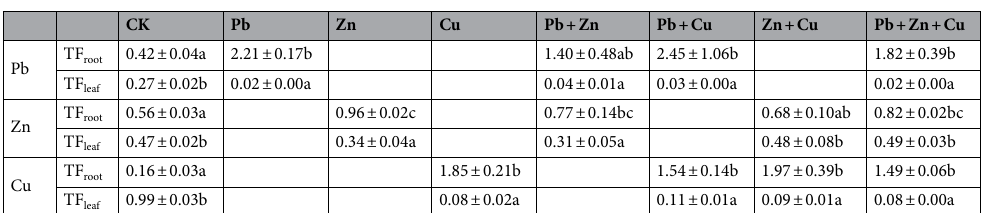
Table 1. Transfers of heavy metals from sediments to Kandelia obovata under individual and combined stresses. Values are the mean of three replicates and within each line, those not followed the same letters are significantly different ( P < 0.05).